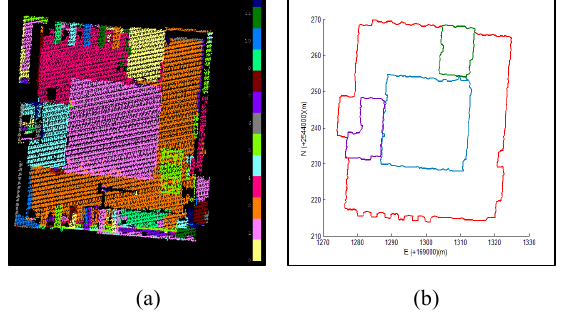
Figure 8. An example of extracted building outline and structure lines: (a) the image of segmented point clusters of the roof points; (b) the results of extracted boundary